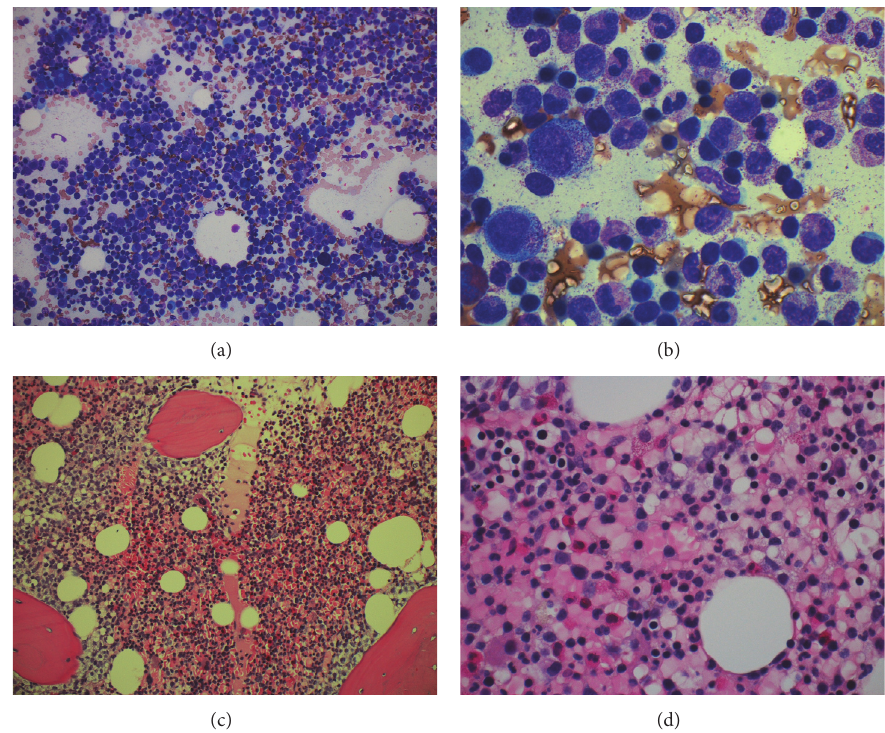
Figure 1: Myeloid hyperplasia with prominent granulation and a shift to immaturity consistent with growth factor (G-CSF) effect. (a) Bone marrow aspirate low power (20x), (b) bone marrow aspirate high power (100x), (c) bone marrow core biopsy (20x), and (d) bone marrow core biopsy